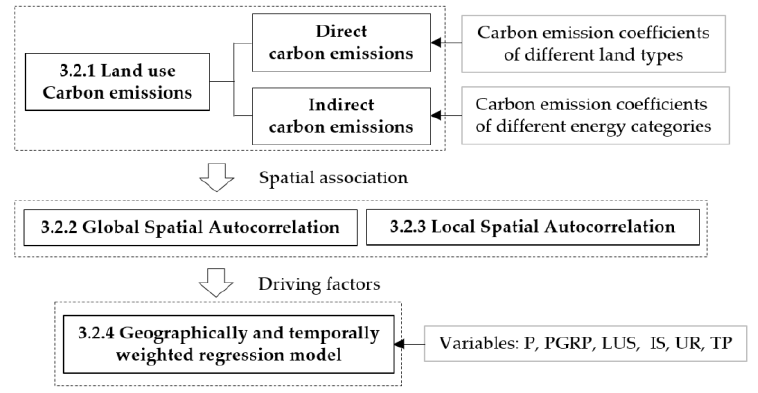
Figure 2. Flow diagram of the methodology.